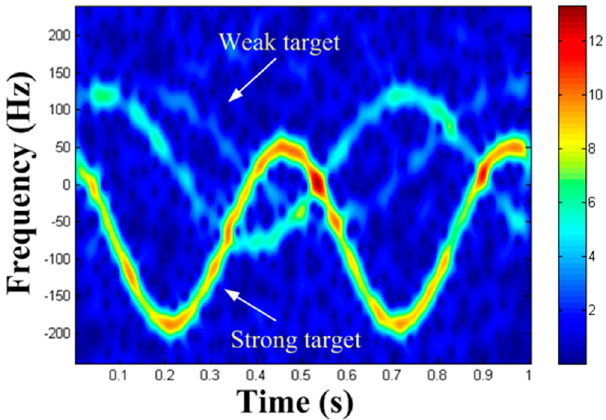
Figure 2. Time-frequency (TF) distribution of three micro-motion (MM) targets with different reflection coefficients.